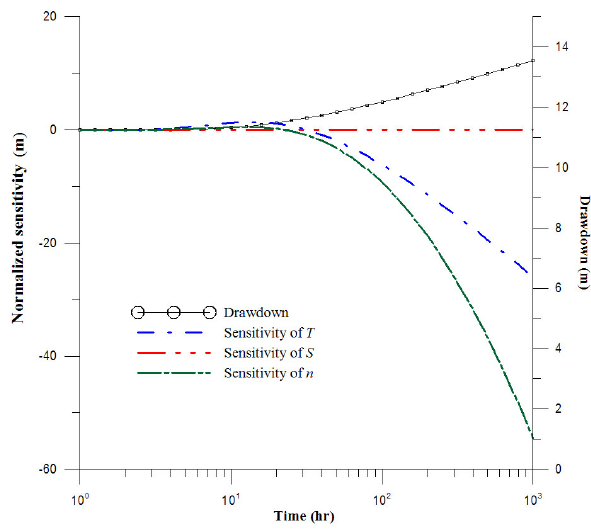
Fig. 8. The time-drawdown data and the sensitivities of the hy- draulic parameters T , S and the flow dimension n .